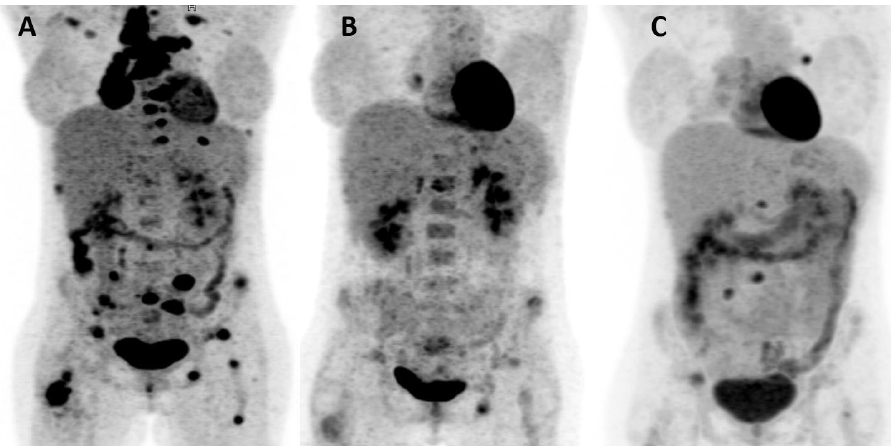
Figure 2. PET-CT prior to treatment ( A ), showing remarkable response after 2 cycles of chemoim- munotherapy and multi-site radiotherapy ( B ) and slight progression with a new PET-avid left hilar lymph node and a bone metastasis in L3 ( C ).